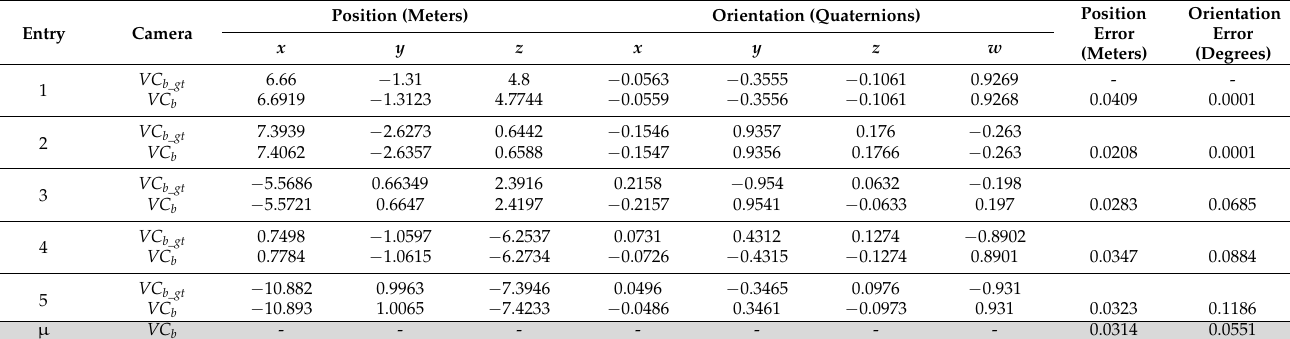
Table 1. Comparison between the ground truth (represented by the VC b_gt camera) and the positions and orientations computed with PnP ( VC b